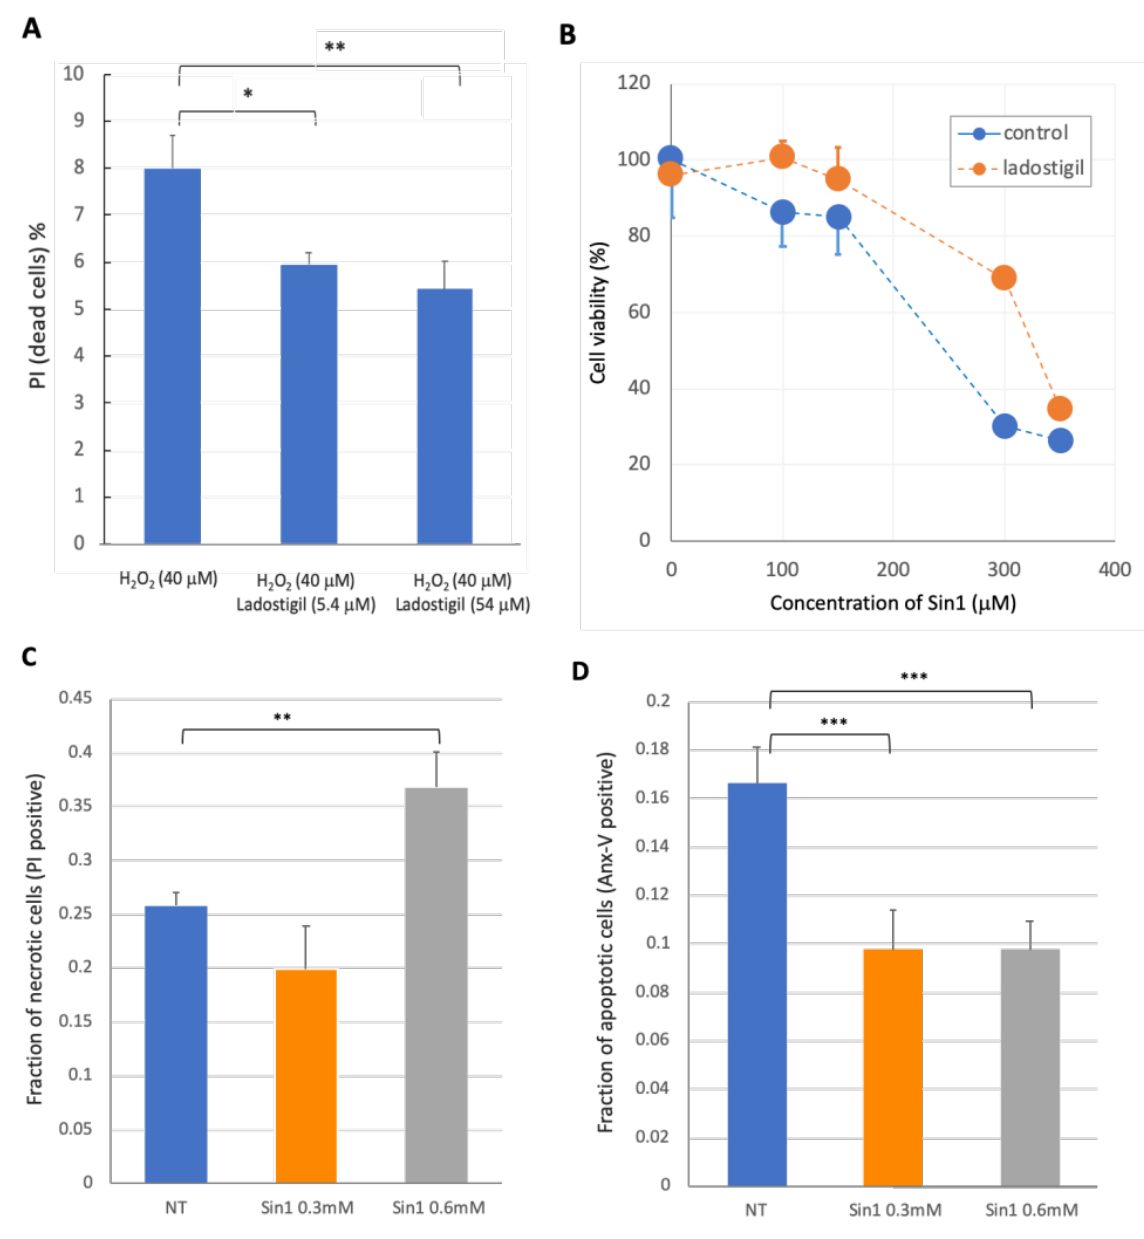
Figure 1. Flow cytometry analysis in cells under oxidative stress conditions in response to treatment with ladostigil. ( A ) Results from FACS analysis with 50k cells per experiment. The fraction of live and dead cells upon 40 μ M H 2 O 2 and ladostigil treatment was tested at 5 h following stimulus. Asterisks indicate the statistical significance of the results. The attenuation in the fraction of PI-positive cells by ladostigil (5.4 μ M) was substantial ( p -value = 0.02). ( B ) Cell viability upon increasing the concentration of Sin1 with and without the presence of ladostigil (5.4 μ M, with mean and standard error; s.e.). Each data point is based on 8 replicates. ( C ) Results from 3 repeated experiments with mean and standard deviation (s.d.) from the flow cytometry run of SY-SY5Y cells treated with Sin1 for 5 h. All measured data were from FACS that was repeated in triplicate. The total FACS cells was considered as 100%, and the percentage of them stained with PI is indicated as a fraction. ( D ) Results from triplicate experiments with the mean and standard deviation (s.d.) from the flow cytometry run for Annexin-V of SY-SY5Y cells treated with Sin1 for 5 h. NT indicates cells non-treated with Sin1. Asterisks indicate the t-test statistical results with p -values of < 0.005 (***), <0.01 (**), and <0.05 (*).